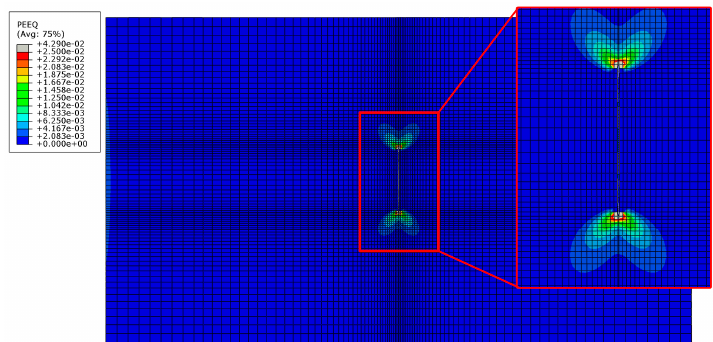
Figure 12. The plastic strain around the crack tip of the Al plate.